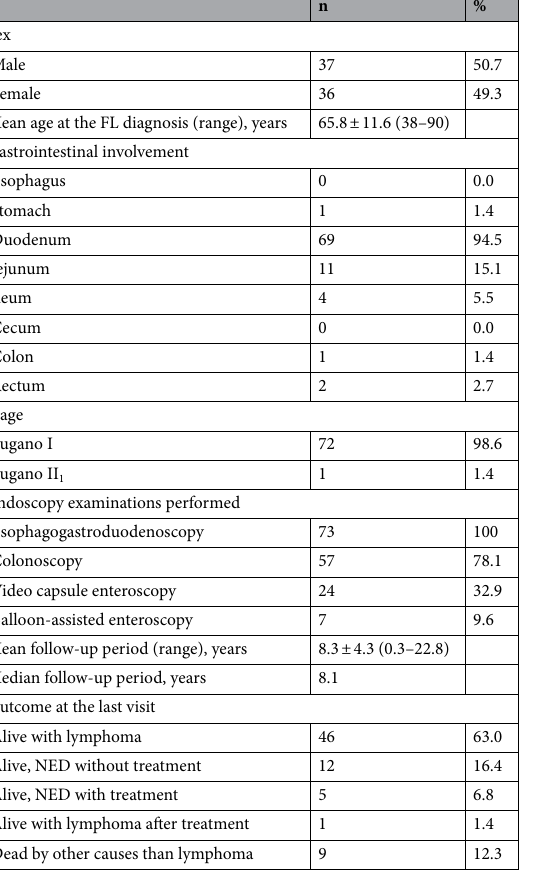
Table 1. Clinical characteristics of the study patients. FL follicular lymphoma; NED no evidence of